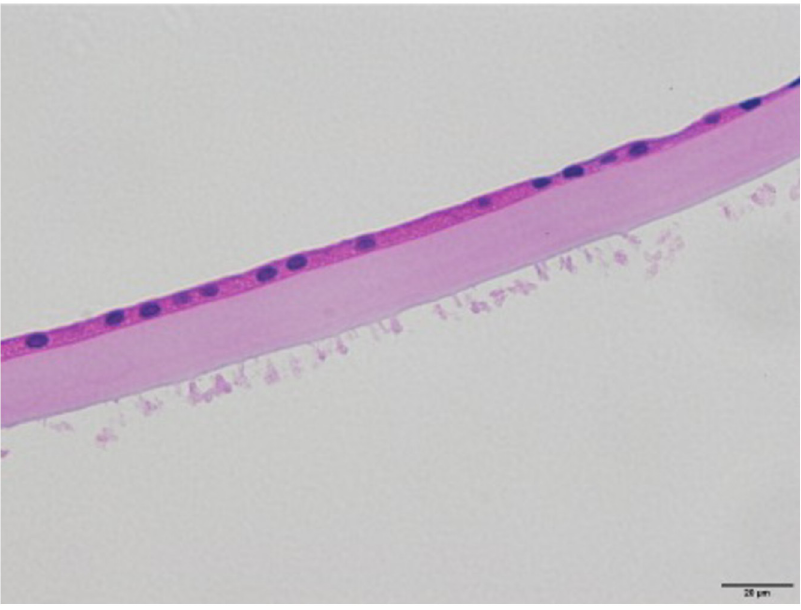
Fig 3. Light microscopic photograph demonstrates classic bush-like deposition of pseudoexfoliation